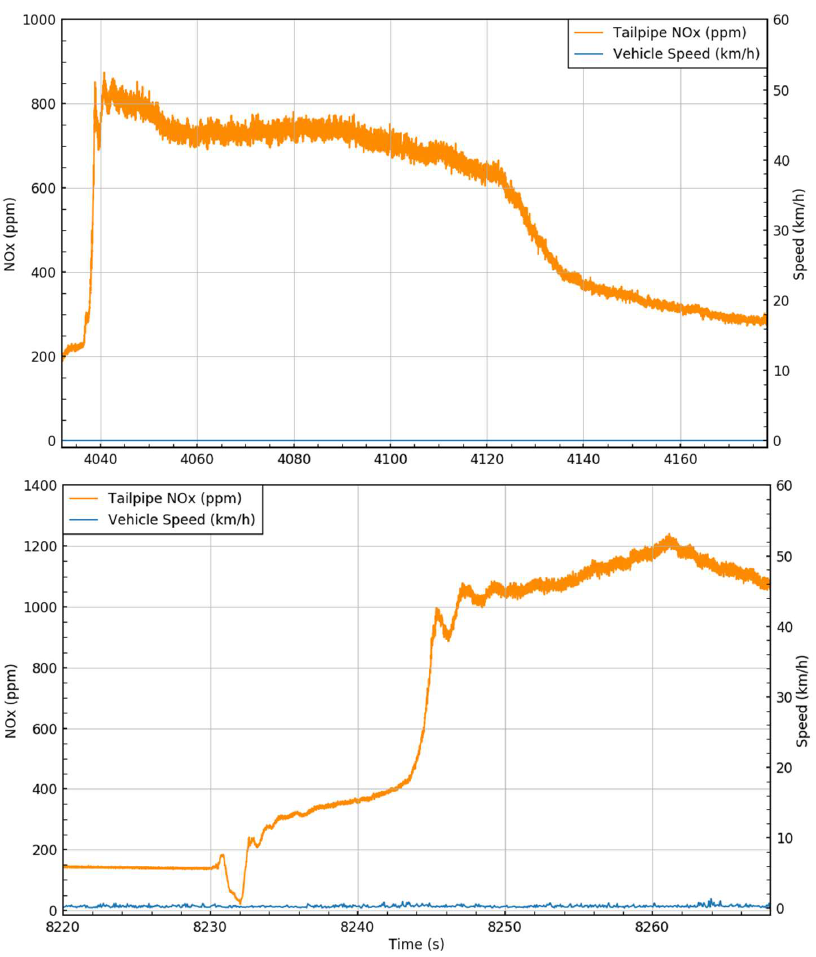
Figure 8. Increase in NO x emissions at idle from the Euro V bus—outside school (T), and in town centre (B).